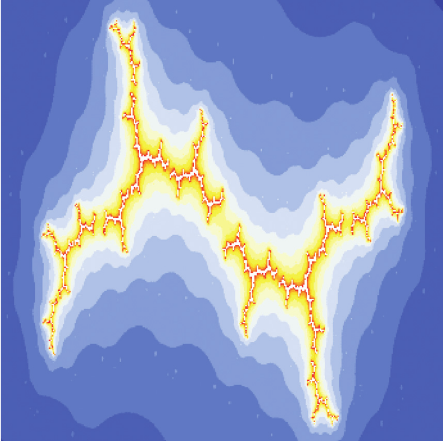
Figure 10: Cubic Julia set in JSOmhh.